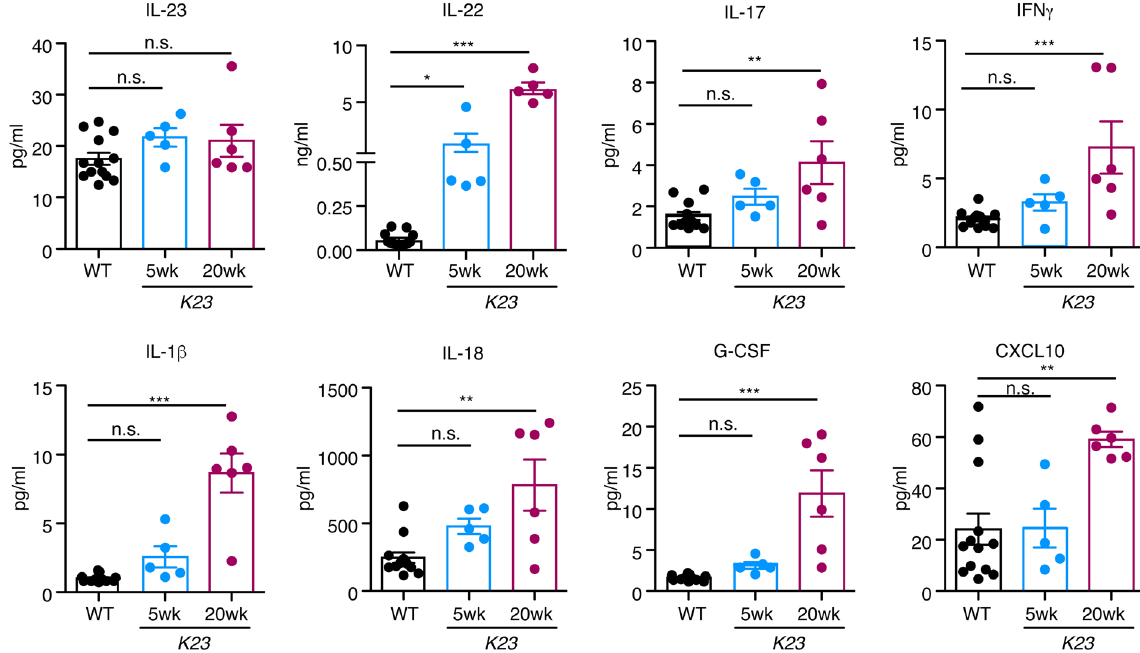
Figure 5. Peripheral cytokine expression after TAM treatment. WT and K23 mice 5 weeks and 20 weeks after TAM treatment serum cytokine levels were analyzed by multiplex ELISA. n = 5–7 mice/group. Data are shown as mean ± SEM, ns, p > 0.05, * p < 0.05, ** p < 0.01, *** p < 0.001, by one-way ANOVA followed by Dunnett’s multiple comparison test.